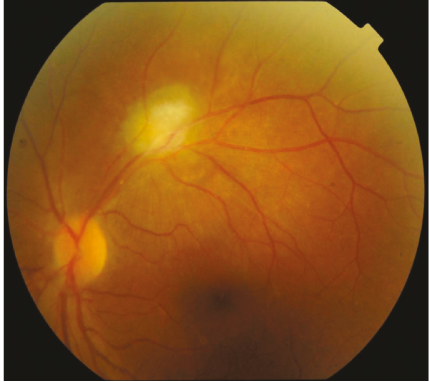
Figure 6: Group II